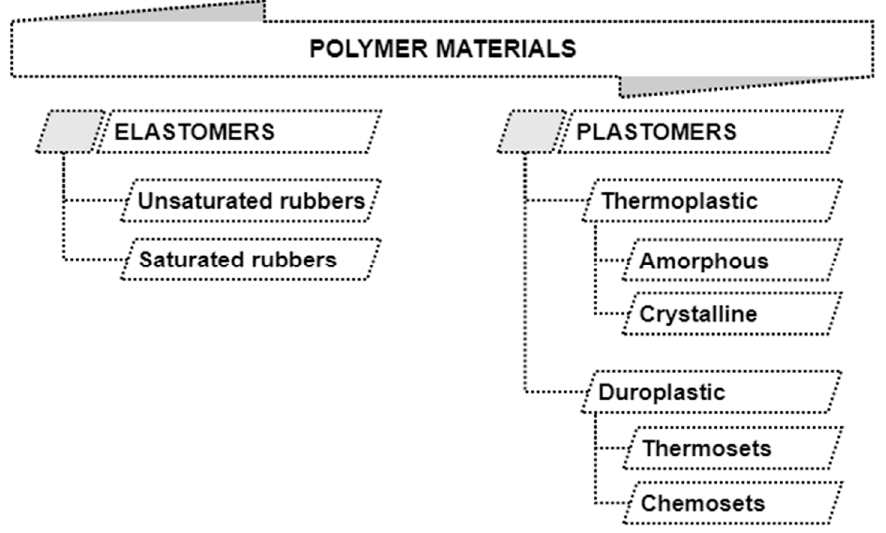
Figure 7. Classification of polymeric materials according to [79,80].